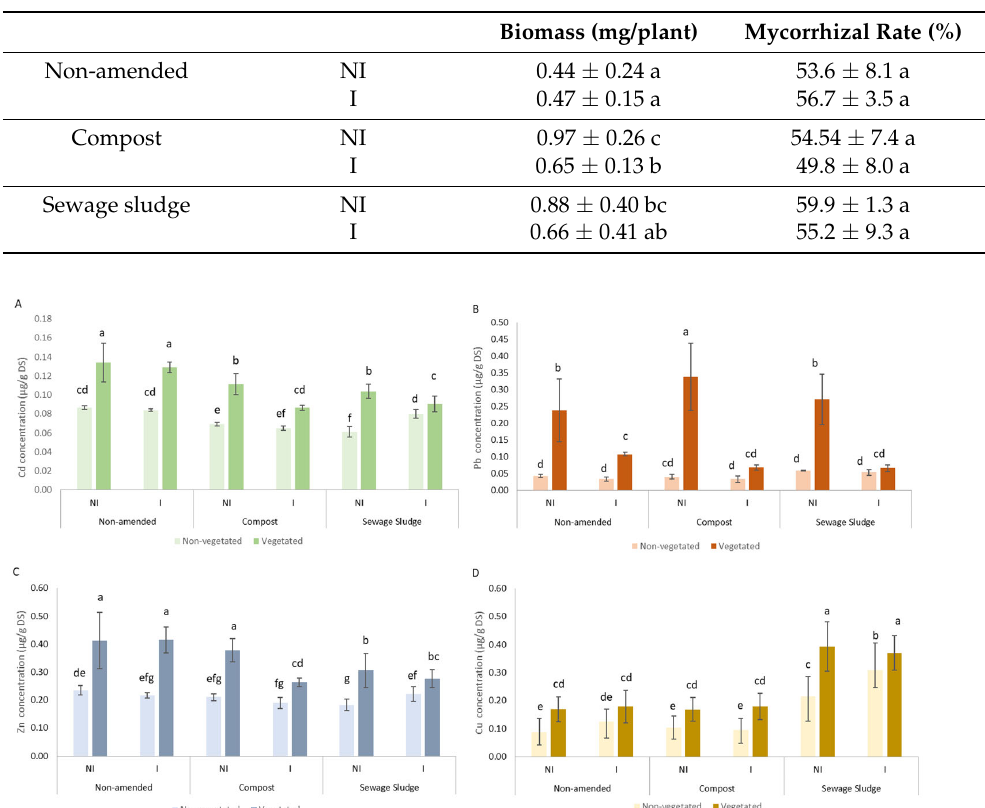
Table 2. Effects of organic amendment application and AMF inoculation on shoot dry weight (n = 30) and mycorrhizal rates (n = 3) of Coriander 3 months after planting. Different letters indicate significant differences between the treatments ( p < 0.05).